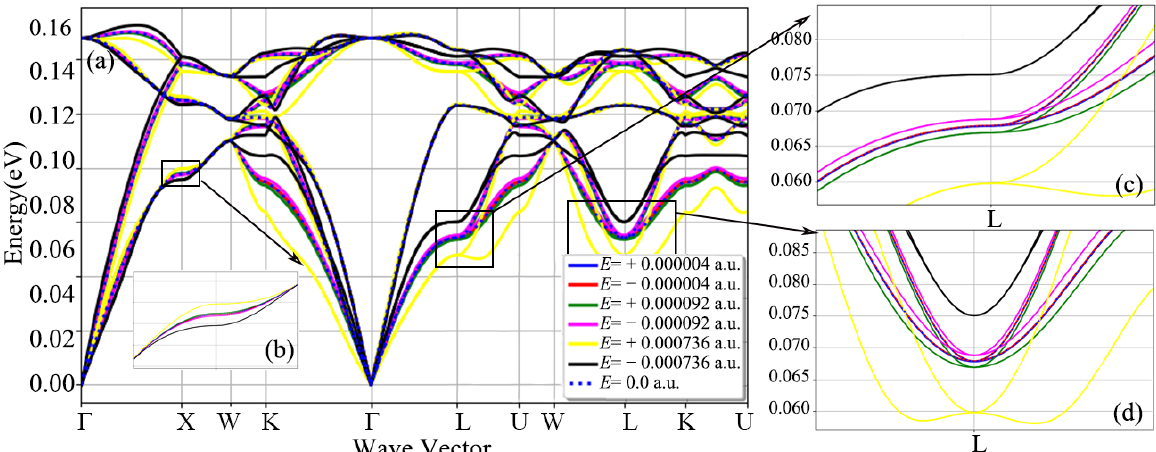
Figure 6. Phonon spectra of diamond primitive cells with fixed lattice structure and atomic positions after applying different electric fields in the [111] crystallographic direction: ( a ) full phonon dispersion diagram along a high symmetry path, ( b – d ) are the phonon dispersion relation curves at point X, point L and point L, respectively.